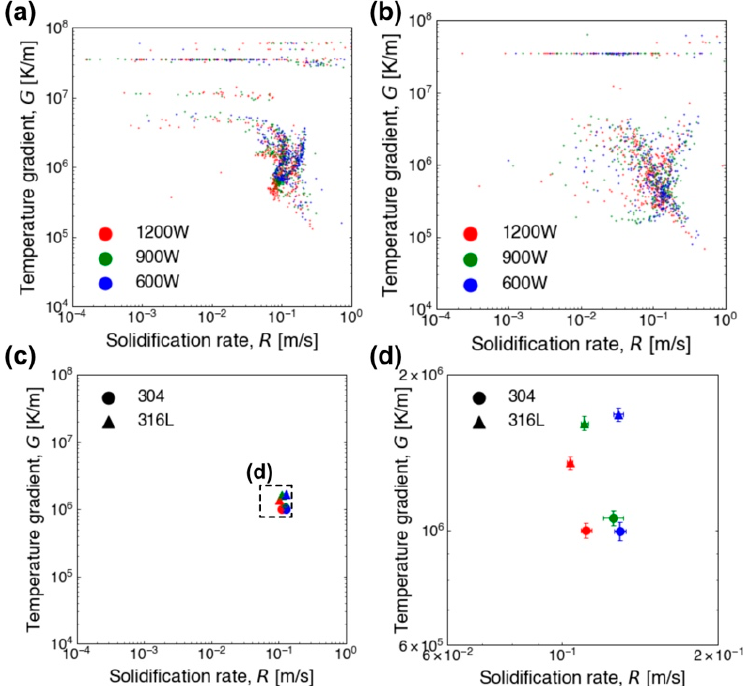
Figure 10. G – R plots of ( a ) 316L and ( b ) 304 SSs colored by the beam power. ( c ) Average solidification conditions of each process parameter, and ( d ) magnified picture of ( c ). Only equiaxed crystalline grains were formed in the 304 SS under the whole range of solidification conditions obtained in this study. On the other hand, equiaxed crystalline grains appeared in the high G region, whereas columnar crystals appear in the low G region in the G – R map of 316L SS. This relationship between the microstructures and solidification conditions is contrary to that predicted by the CET